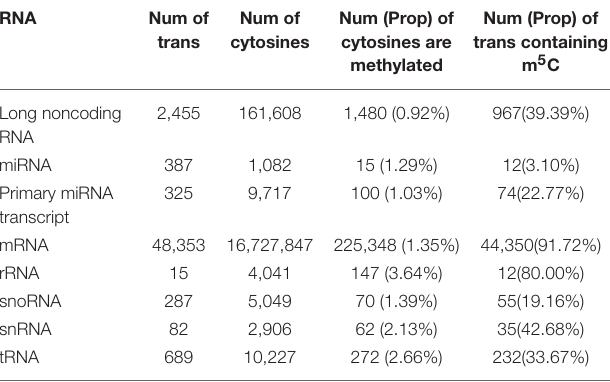
TABLE 2 | Candidate m 5 C modifications in different types of RNAs. Num: number, Prop: proportion, trans: transcripts.